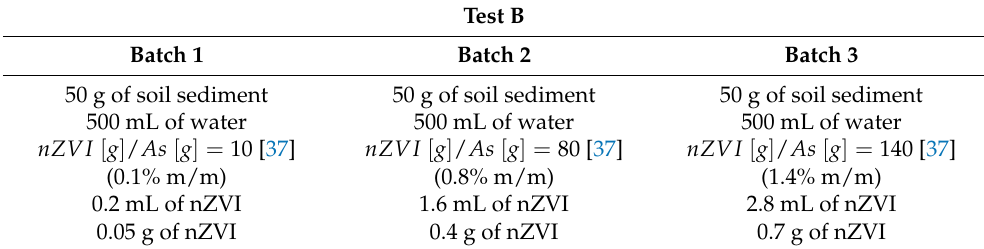
Table 4. Batch compositions (Test B).